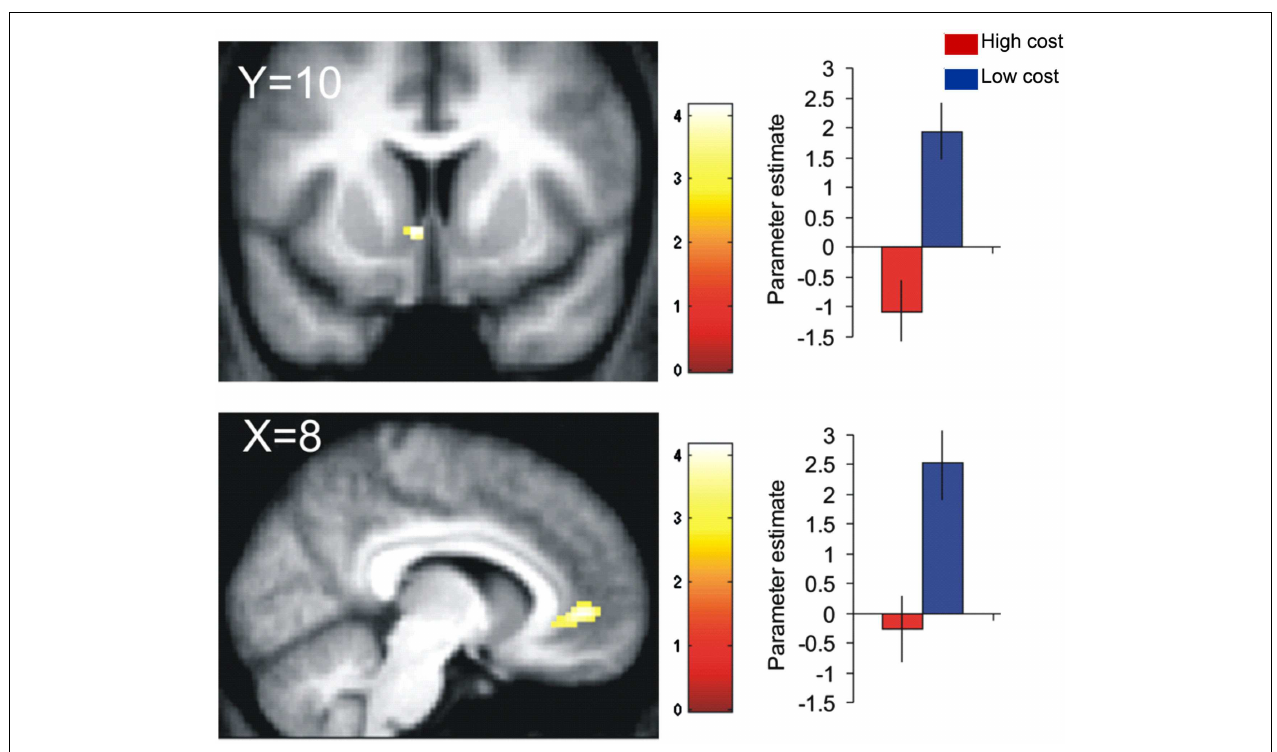
mild electric stimulation.This correlation was attenuated in the high-cost condition (red), in which participants decided between mixtures of money and painful electric stimulation. Figure adapted from Talmi et al.